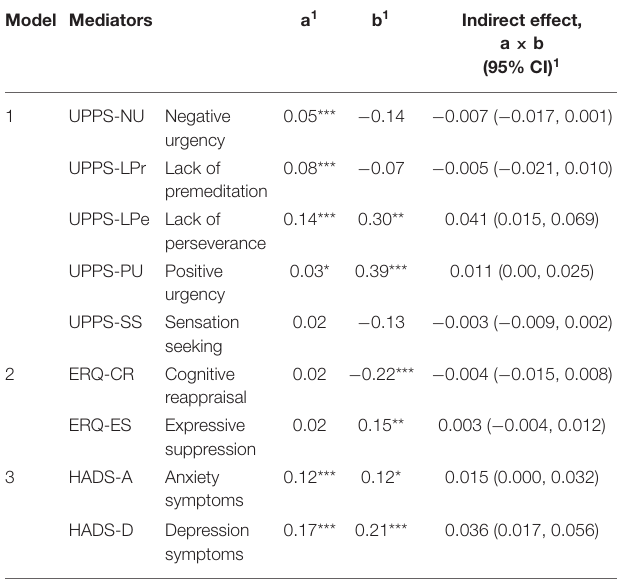
TABLE 4 | Mediation models of the association between adult ADHD symptoms and PIU. Model Mediators